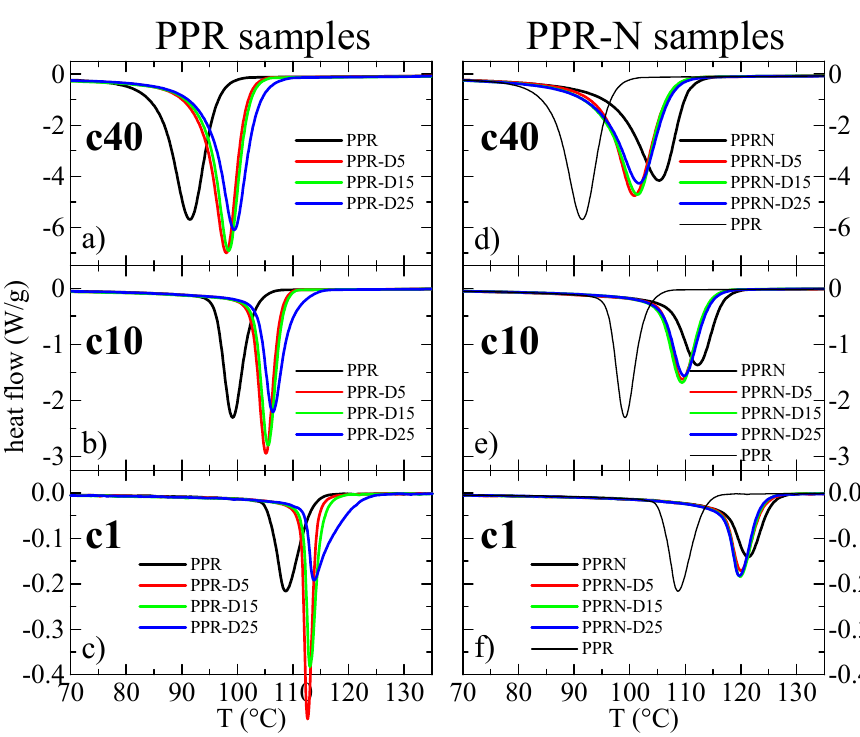
Figure 5. DSC cooling curves for the different samples: ( a – c ) curves from cooling of the melt at 40, 10, and 1 °C/min, respectively, for the PPR samples; ( d – f ) curves from cooling of the melt at 40, 10, and 1 °C/min, respectively, for the PPR-N samples. The curves for sample PPR are also included in the diagrams for the nucleated samples as references in order to better quantify the nucleation ability. All curves were normalized to the actual polymer content in the sample.